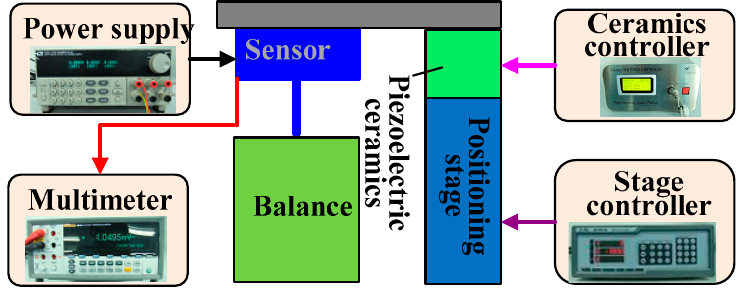
Figure 13. The setup for force sensor calibration.